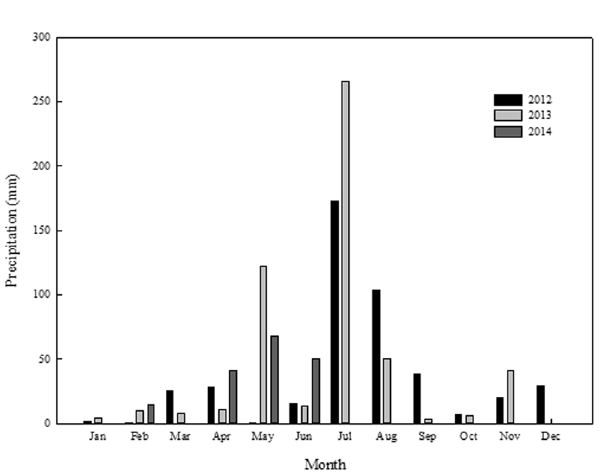
Figure 7. Monthly precipitation in 2012, 2013 and 2014. Precipitations from July to December were not measured in 2014. Data was obtaind by the Jining Meteorological Bureau (http://www.jnqxj.gov.cn/).